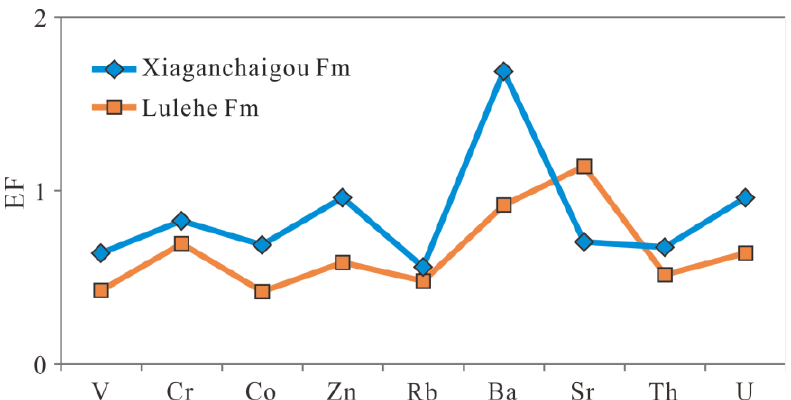
Figure 6. Comparison of trace elements between samples and average shale. EF (enrichment factor) = Csediment/Cstandard rock. Table 3. Trace element contents of the Paleogene in the Pingtai area.